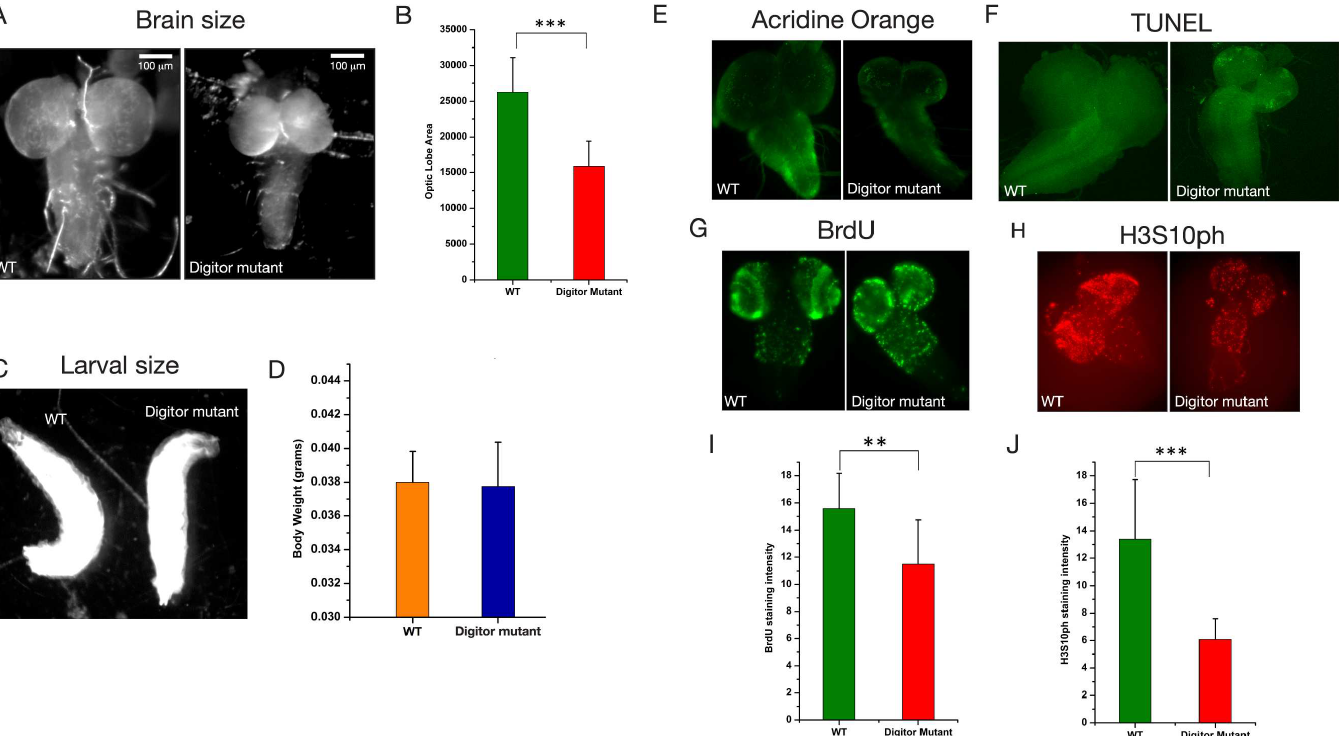
Fig 8. Digitor mutant third instar larvae have a severelyreduced brain size. (A) Images of dissected brains from wild type (WT) and Digitor mutant ( EP(3) 3709/EP(3)3709 )third instar larvae at the same scale. (B) Comparisonof the averagearea of the two optic lobes from 20 brainsof wild type and Digitor mutant larvae with S.D., respectively.The difference in size was statistically significant(P value < 0.001, Student’s two-tailedt-test). (C) Images of wild type and Digitor mutant third instar larvae side by side. (D) Comparison of the averagefrom four determinations of the body weight of 22 wild type and Digitor mutant larvae with S.D., respectively.The difference in weight was not statistically significant(P value (cid:21) 0.8, Student’s two-tailedt-test). (E) AcridineOrange labelingof brains from wild type and Digitor mutant larvae. (F) TUNEL labelingof brains from wild type and Digitor mutant larvae. (G) BrdU incorporation into brains from wild type and Digitor mutant larvae. (H) Anti-H3S10phantibody labelingof brains from wild type and Digitor mutant larvae. (I) Comparison of the averagefluorescence intensity of BrdU incorporation from the two optic lobes and thoracic segments from 10 brains of wild type and Digitor mutant larvaewith S.D., respectively.The difference was statistically significant(P value < 0.01, Student’s two-tailedt-test). (J) Comparisonof the averagefluorescence intensity of anti-H3S10ph antibody labelingfrom the two optic lobes and thoracic segments from 8 brains of wild type and Digitor mutant larvaewith S.D., respectively. The difference was statisticallysignificant(P value < 0.001, Student’s